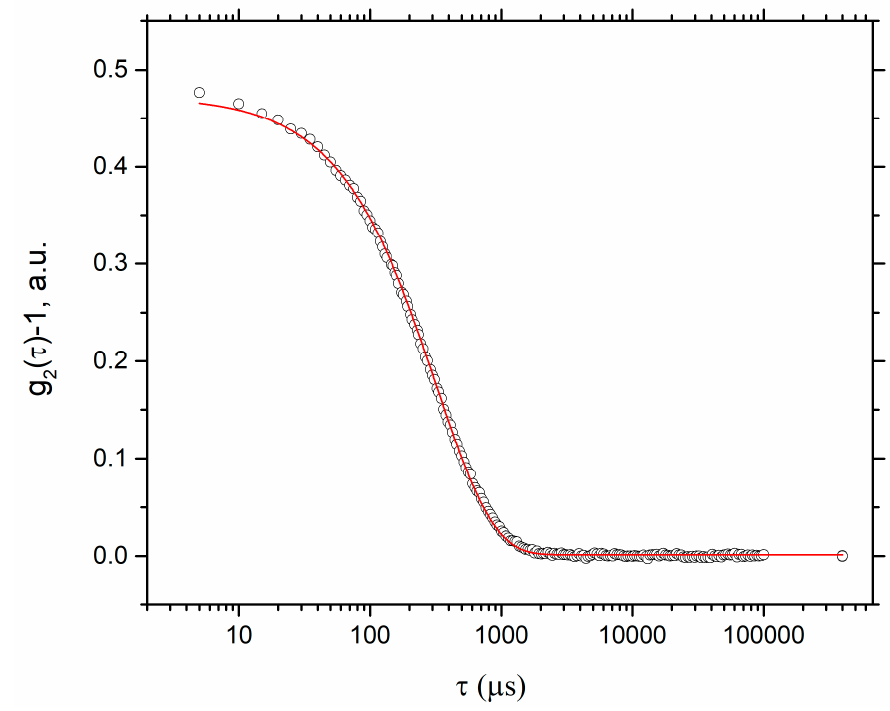
Figure 8. Correlation curve obtained by DLS of the MAT sample at 0.3 g/L at 25 °C.